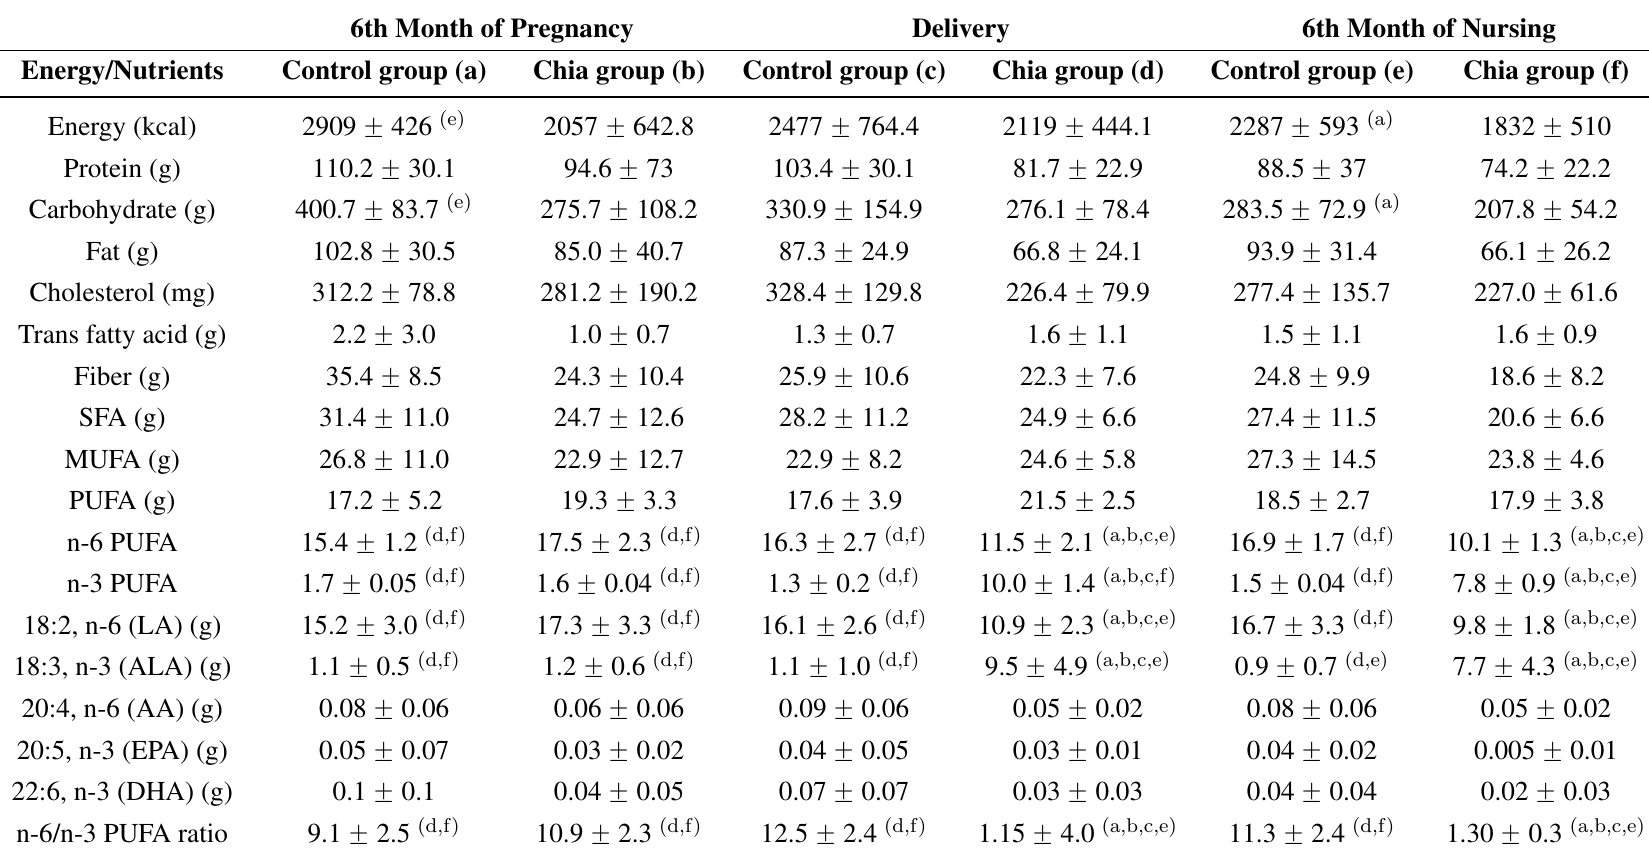
Table 2. Energy and composition of diet ingested by mothers during pregnancy and